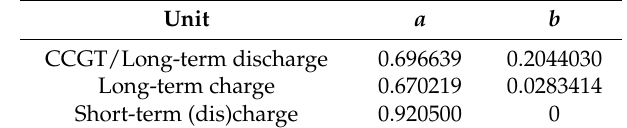
Table 3. Parameters a and b of Equation (15) for MILP.